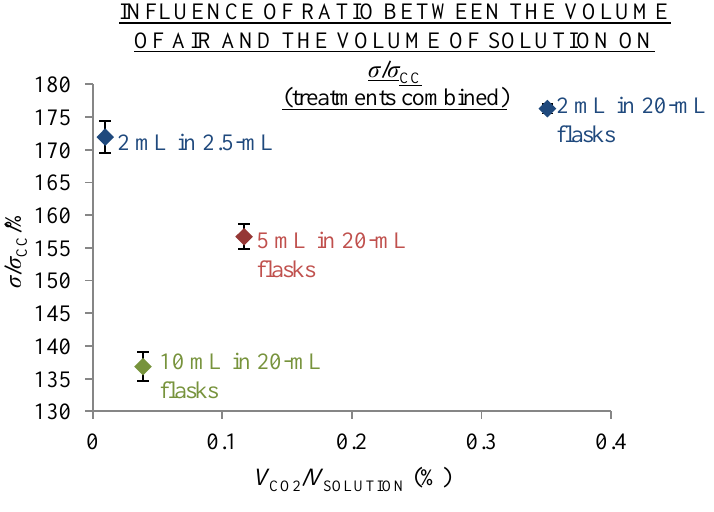
at 25 °C and 1000 Hz with SE intervals as a function CC / V : 28; 0.04%: 10; 0.12%: 10; 0.35%: 8. CO2 SOLUTION